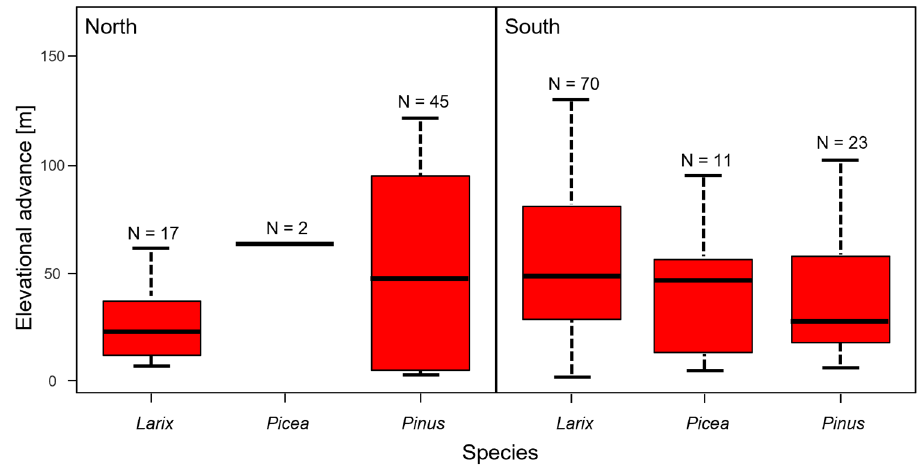
Figure 3. Distance of treeline advance (1972–2012) for north- and south-facing aspects (left and right panels, respectively) separated by the three study species. Distances were computed as the elevational difference between trees classified as tree advance (2012) and the nearest raster cell (1972) of trees recorded in the first field survey. No confidence intervals have been plotted for Picea advance on the north-facing slope due to the extremely small sample size.